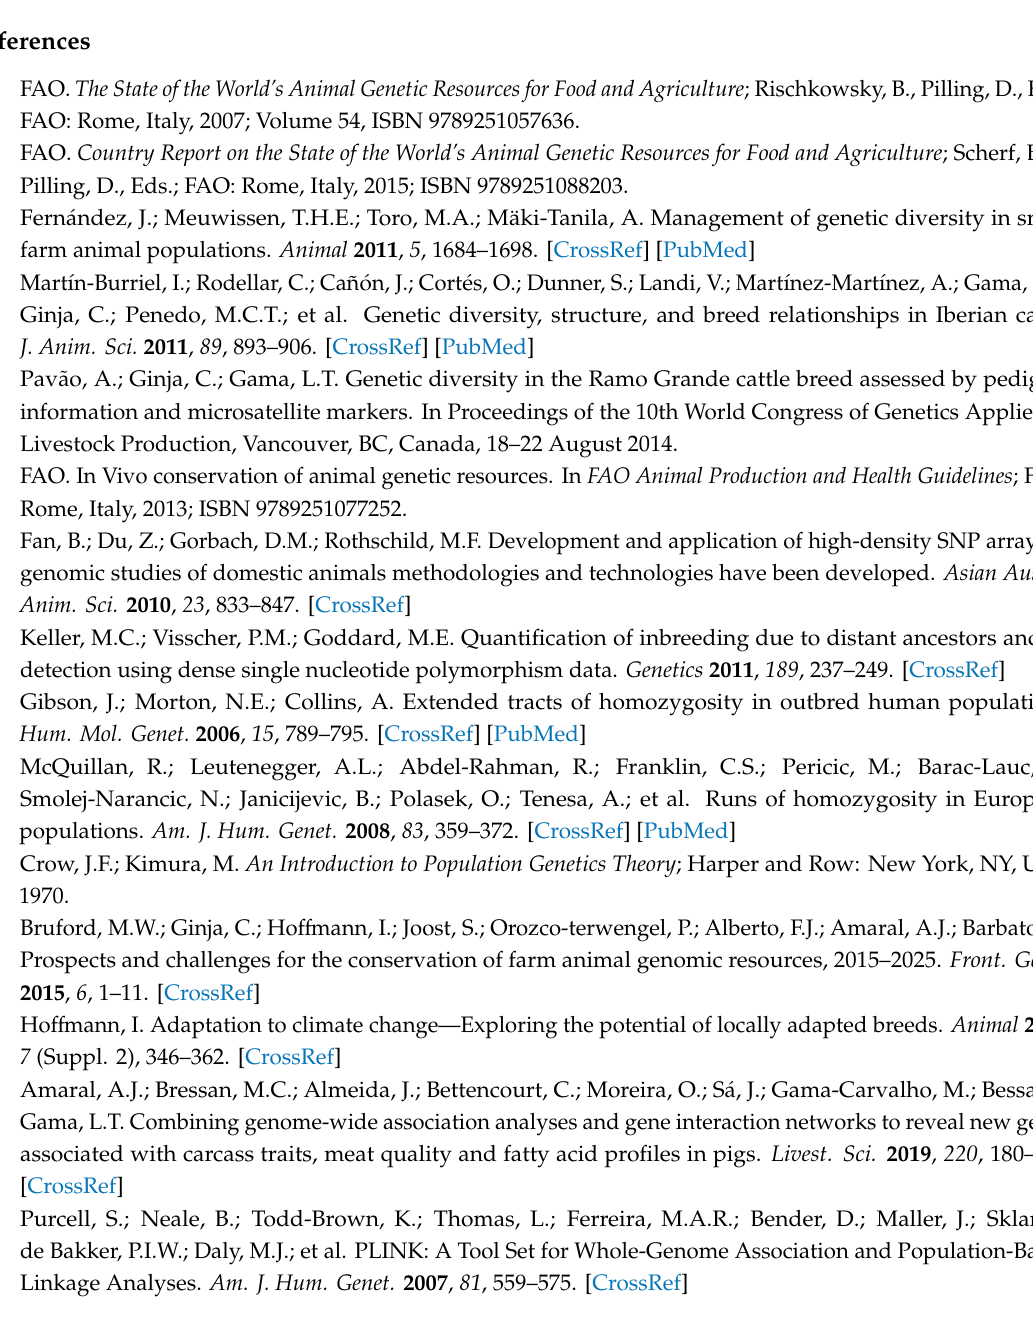
Table S1: Number of ROH segments per chromosome, Table S2: Summary statistics of ROH length (Mbps) per